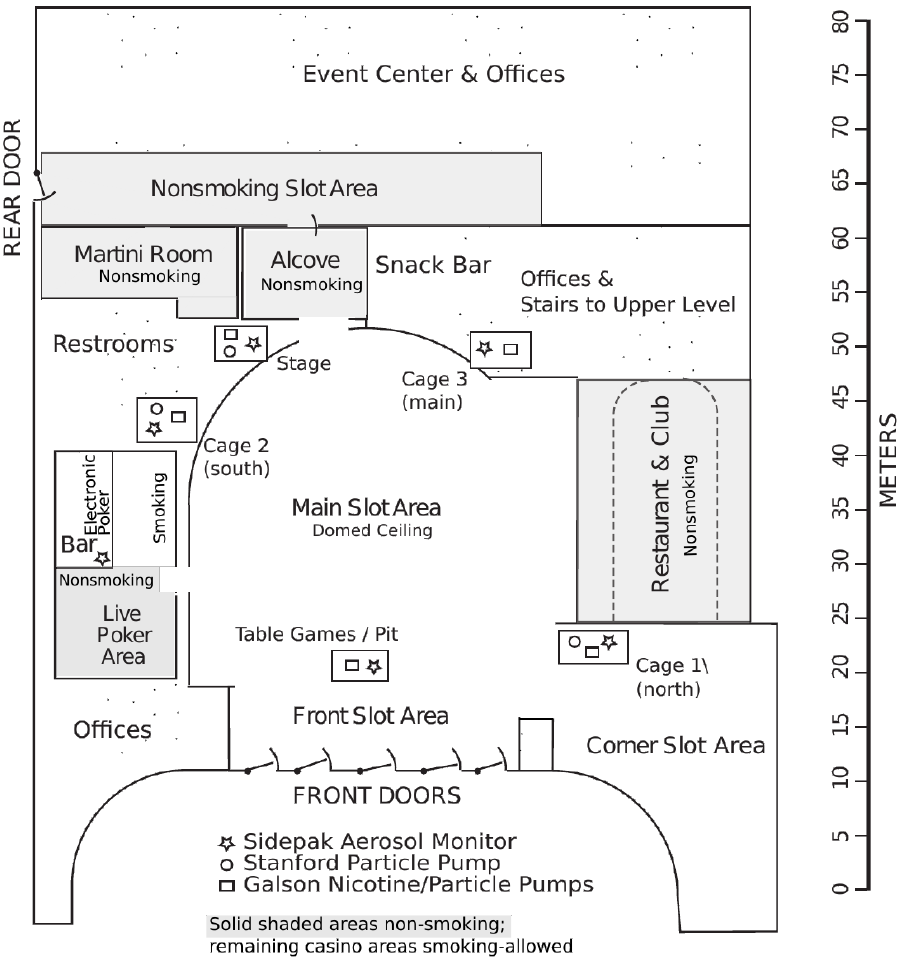
Figure 1. Schematic showing the casino layout and fixed-site air monitoring positions during the 2008 monitoring periods before the smoke-free policy was adopted. The layout was changed slightly in 2011 and further in 2014 subsequent to hotel construction, which was completed in December 2013. The poker area was moved to the martini bar area, and the corner slots area currently opens up to the hotel lobby.